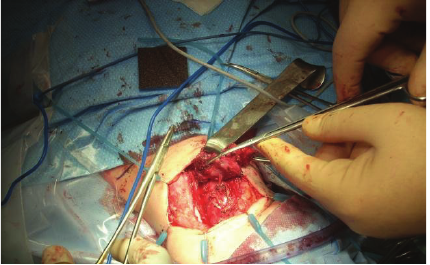
Figure 8: Intraoperative